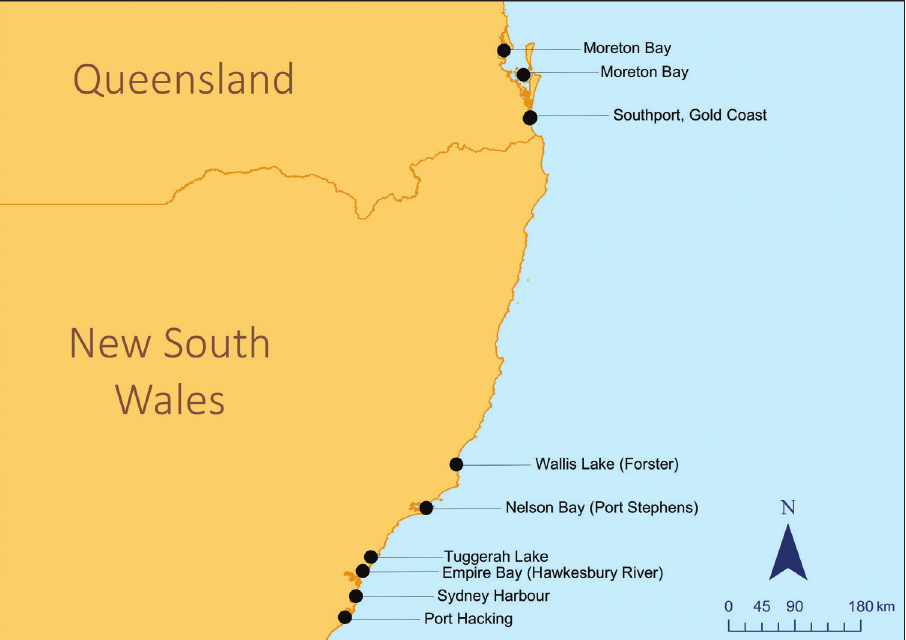
Figure 1. Collection locations for H. procerus in QLD and H. whitei in NSW,